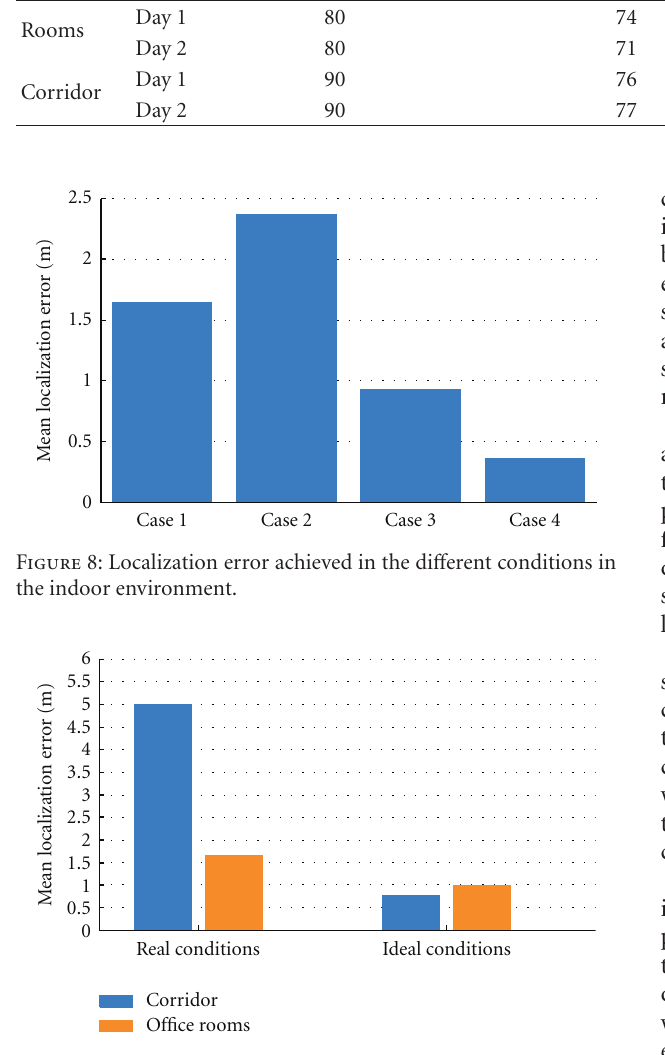
Figure 9: Localization error achieved in the di ff erent conditions and di ff erent types of the indoor